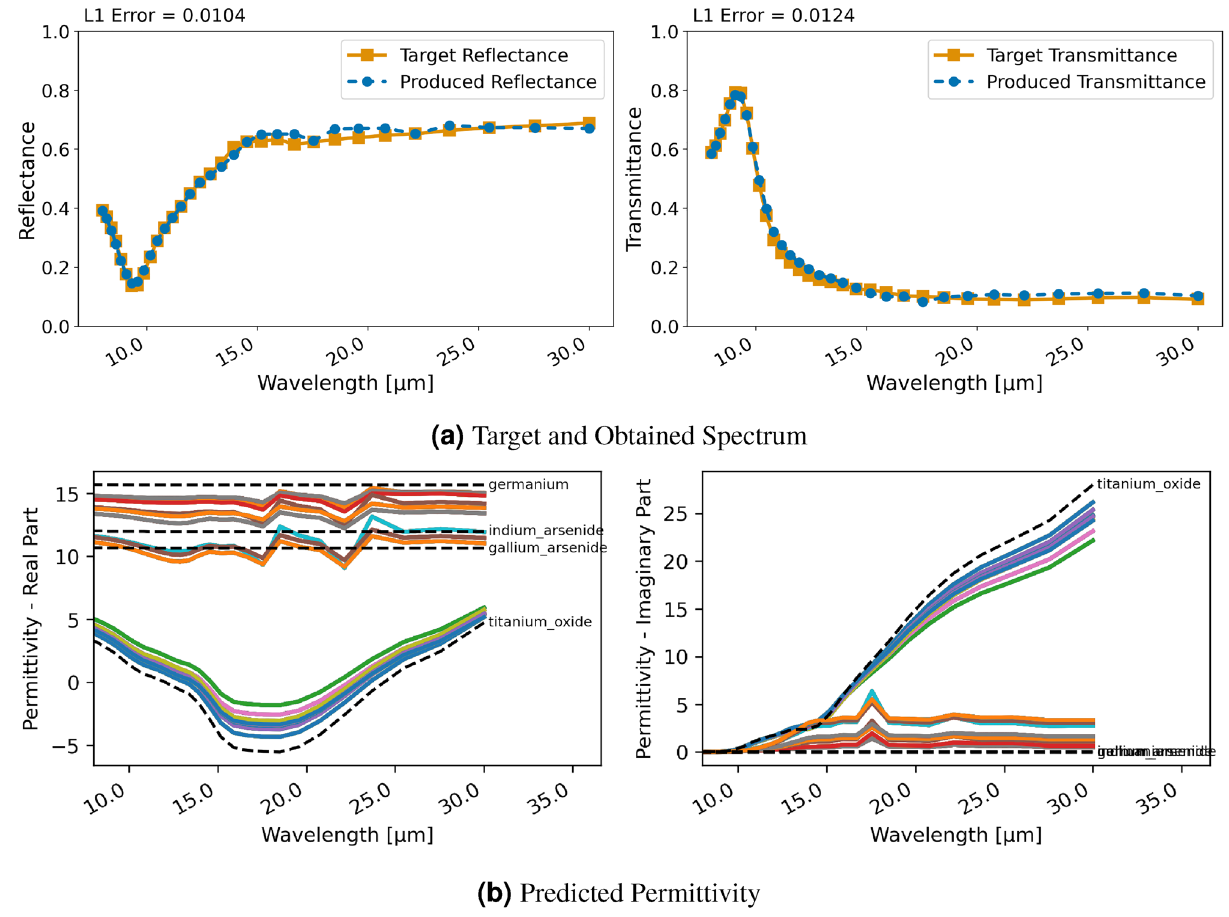
Figure 8. Inversion results for a two-layer patterned material using RCWA and classification; ( a ) displays target and produced spectra, ( b ) each line shows the utilized permittivity for a grid